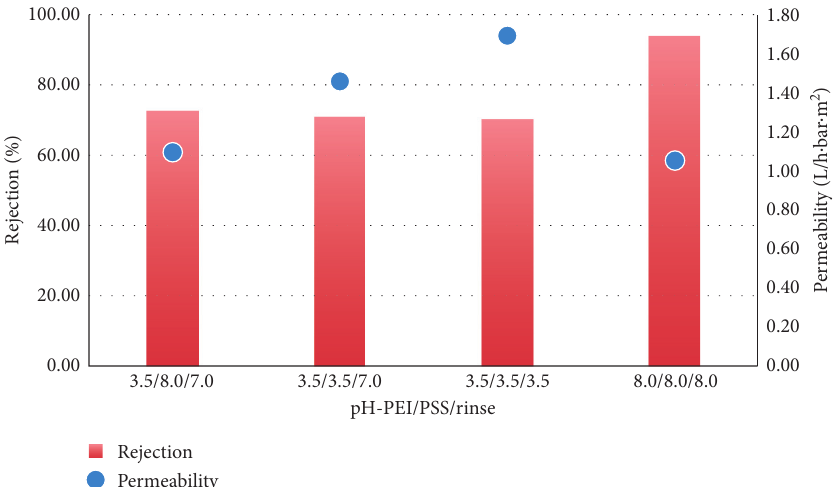
P � 10bar, T � 32.08 ± 0.3 ° C, CFV � 0.65m/s, MgCl 35 (testing condition: